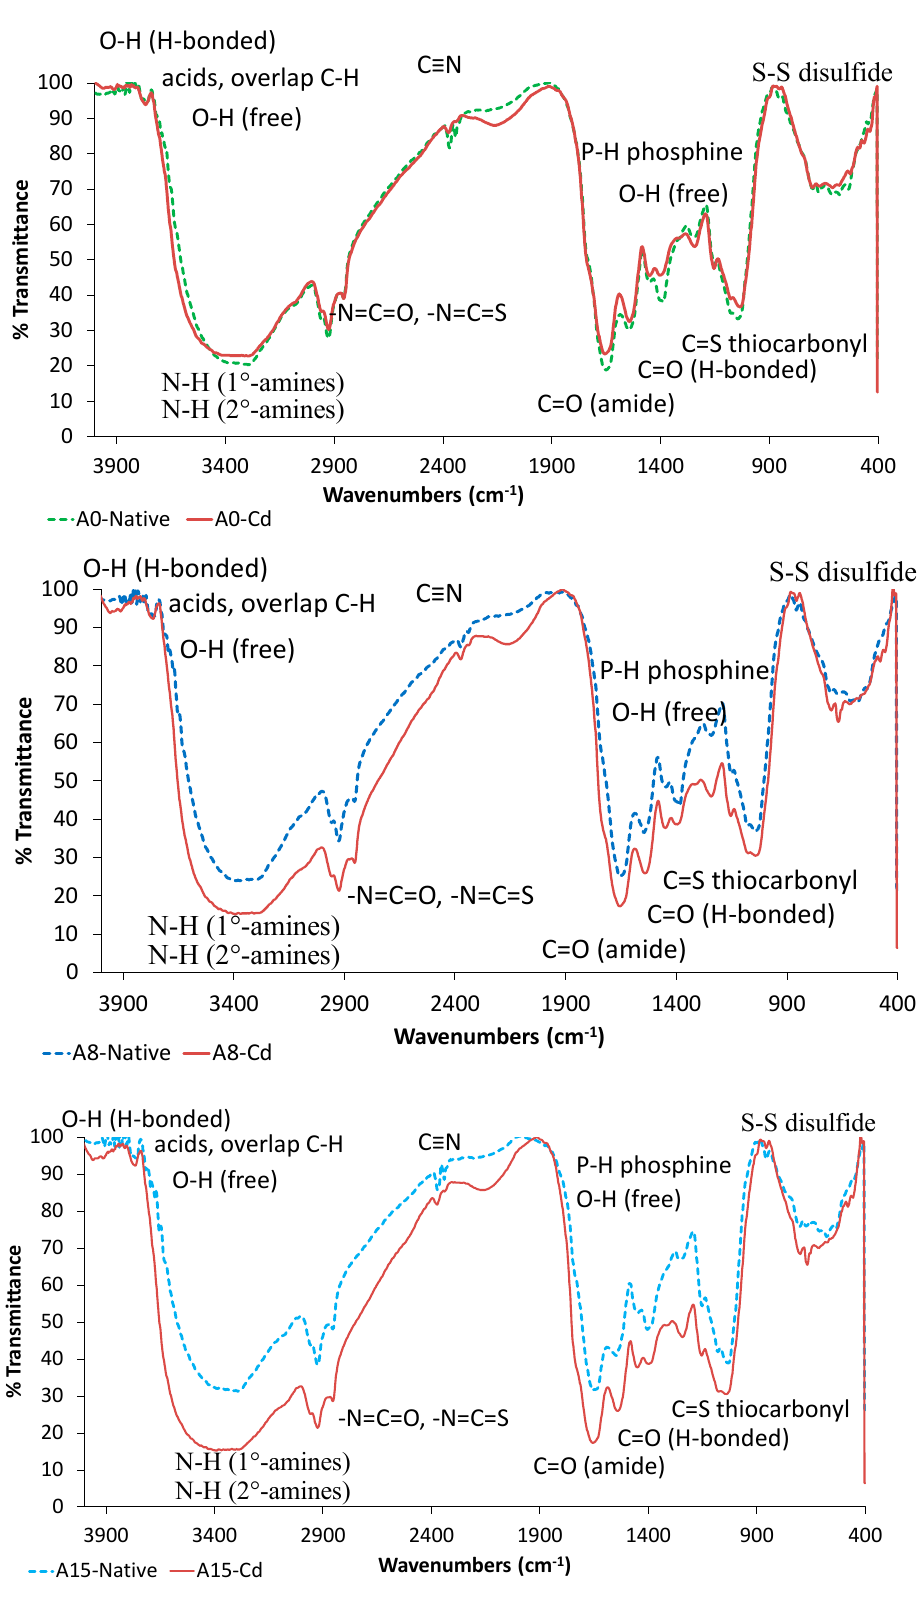
Figure 4. Spectra of dried biosorbent Aphanothece sp. types A0, A8, and A15 before and after Cd 2+ sorption. Table 1. The observed shifting main peaks of FTIR spectra for biosorbent.